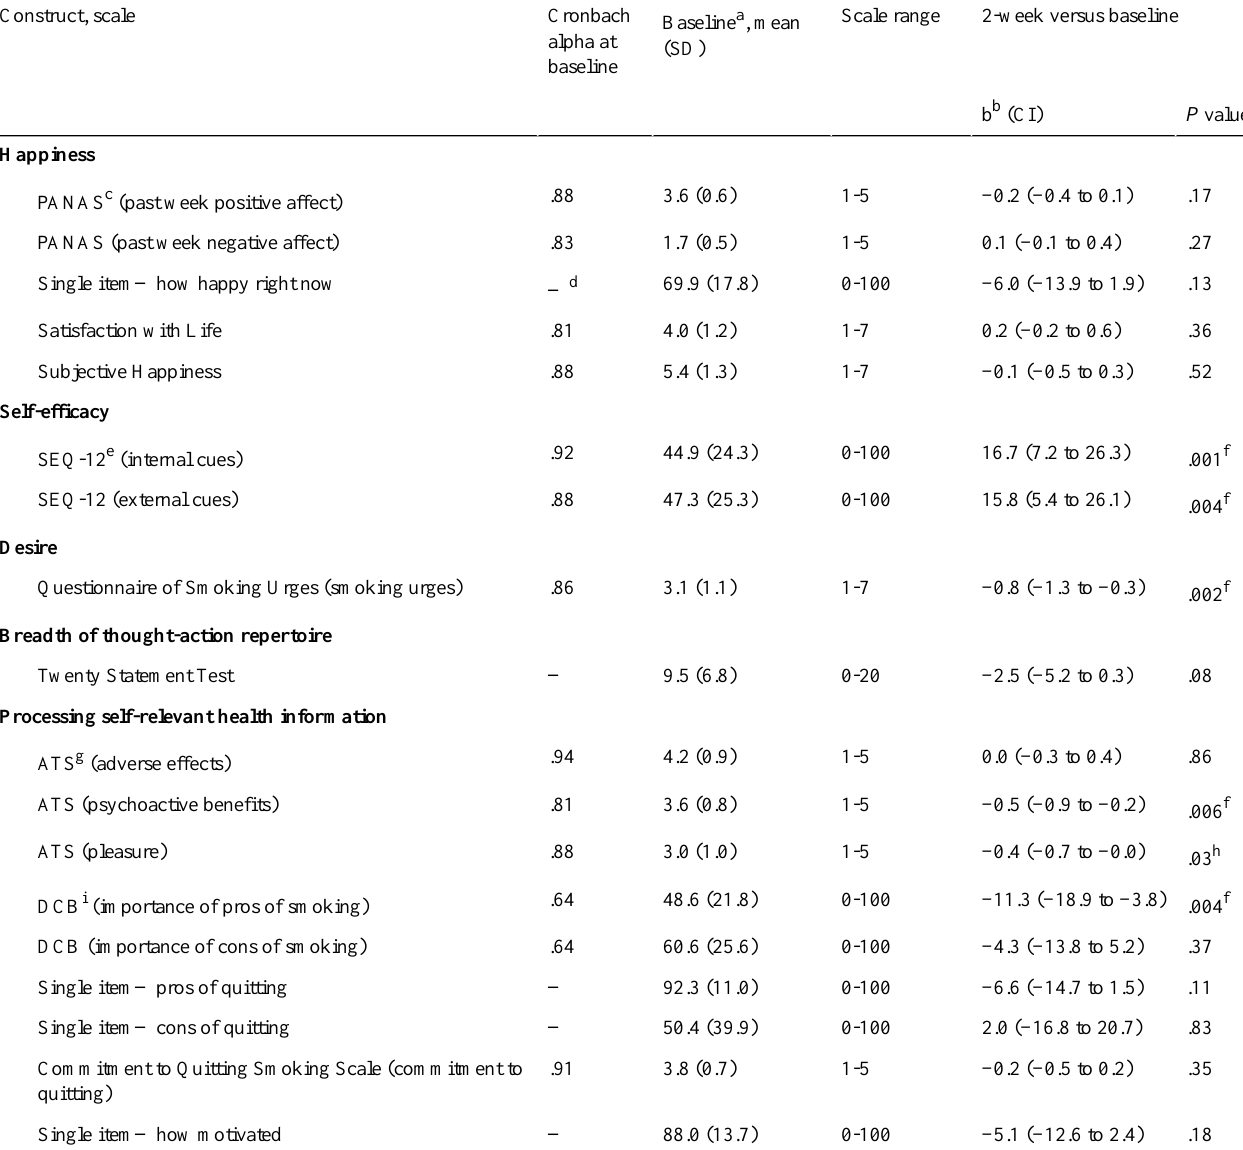
Table 4. Within-person changes on theorized mechanisms of change from baseline to the end of